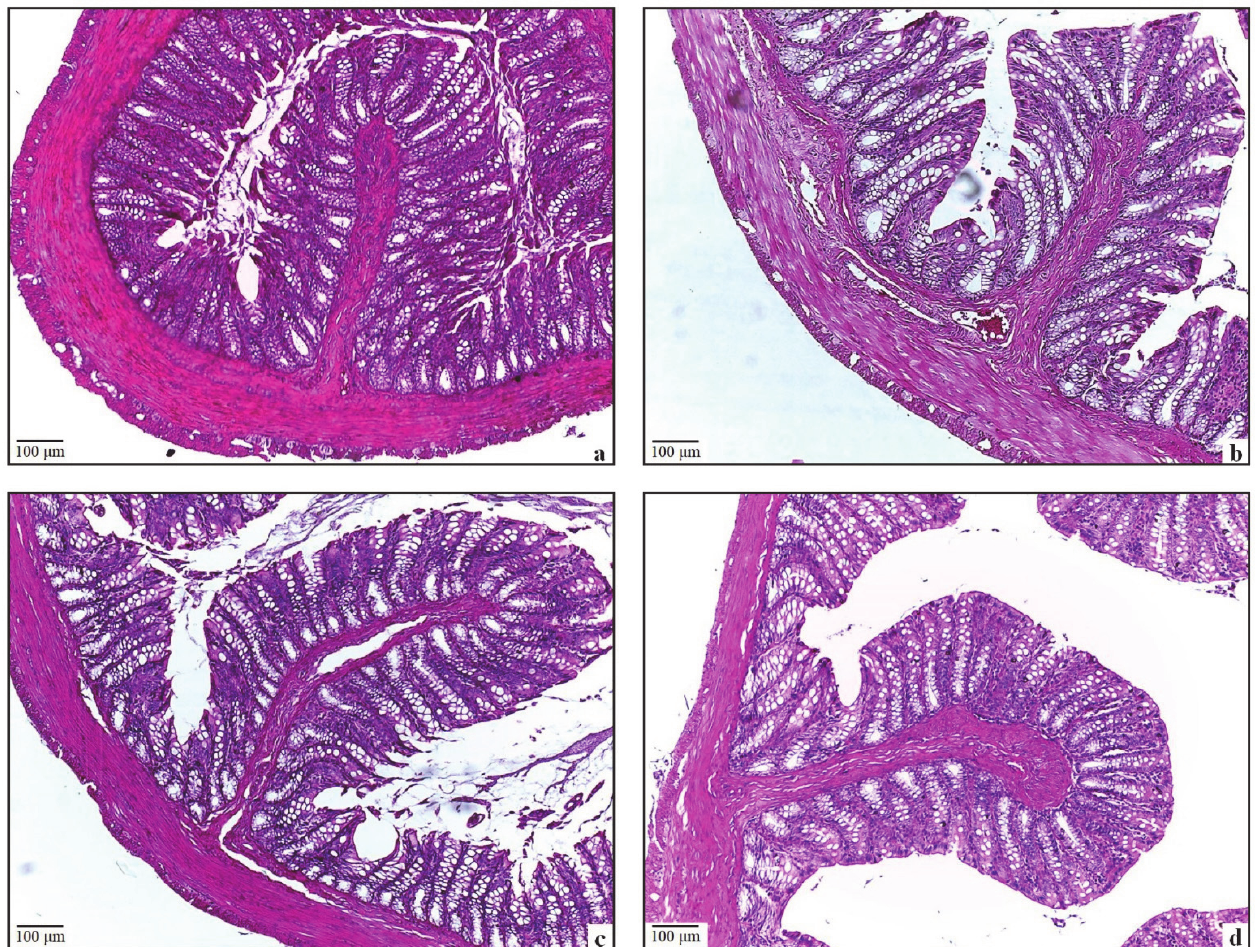
Figure 5. The microscopic images of HE-stained slides of the large intestine tissue. Bar = 100 μ m. ( a ) The image shows a large intestine of the control group. ( b ) The structure in the ALA-only group is similar to the control group. ( c ) Goblet cell density in the Mucositis group was similar to the control and ALA groups, no degeneration was observed in enterocytes. ( d ) The structure in the Mucositis + ALA group is similar to the control group.